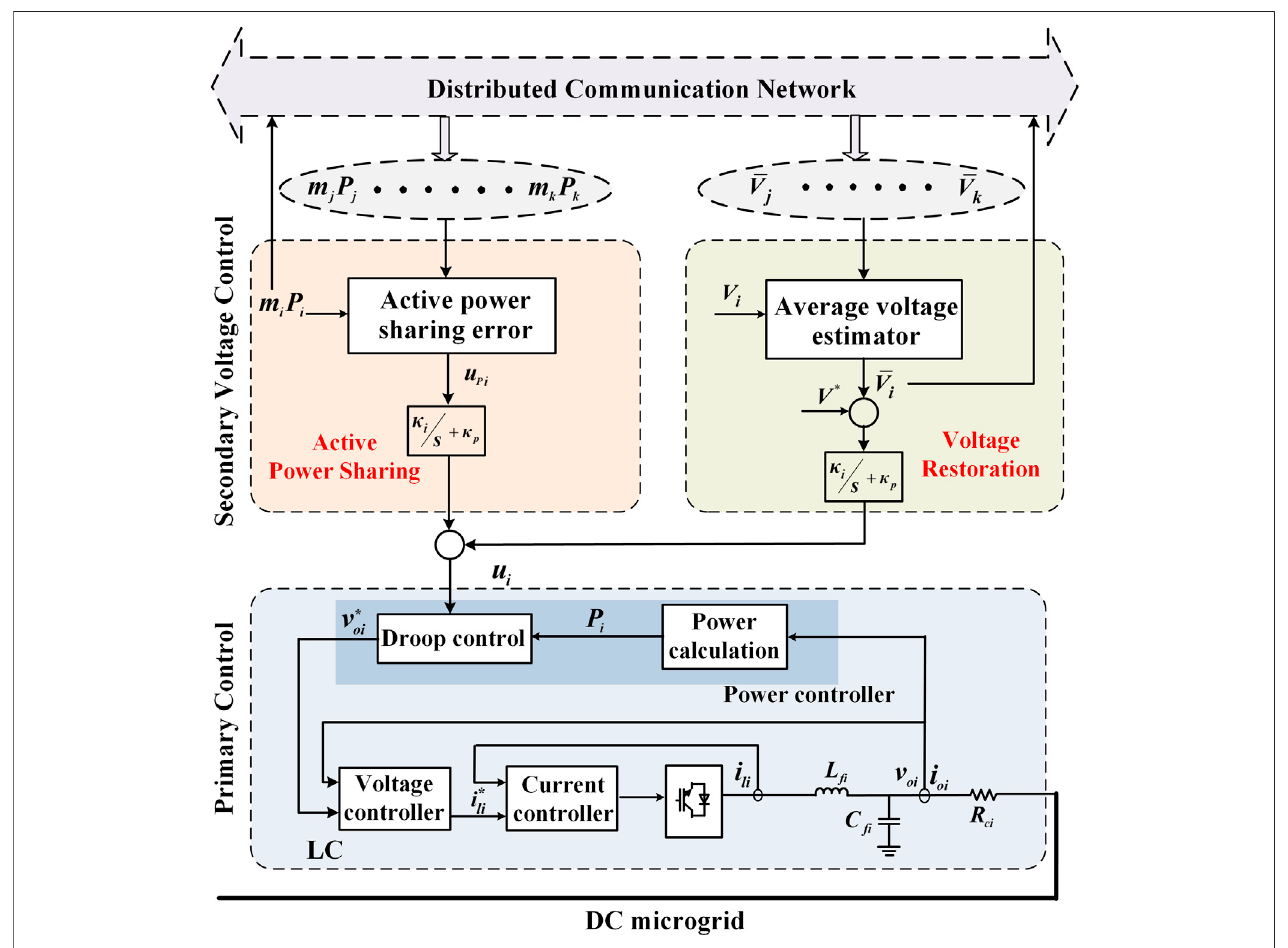
FIGURE 1 | Hierarchical control structure of the DC